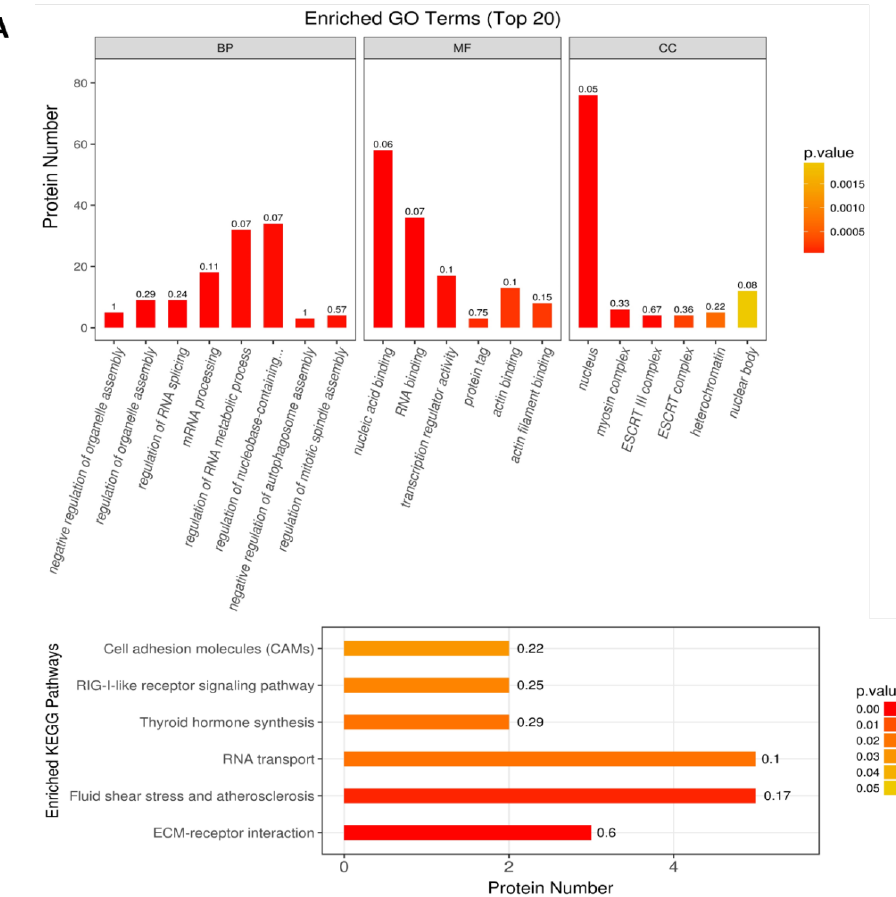
Figure 3. Top 20 enriched, di ff erentially expressed proteins processed of gene ontology (GO) terms and enriched Kyoto Encyclopedia of Genes and Genomes (KEGG) pathways in PSV-infected PK-15